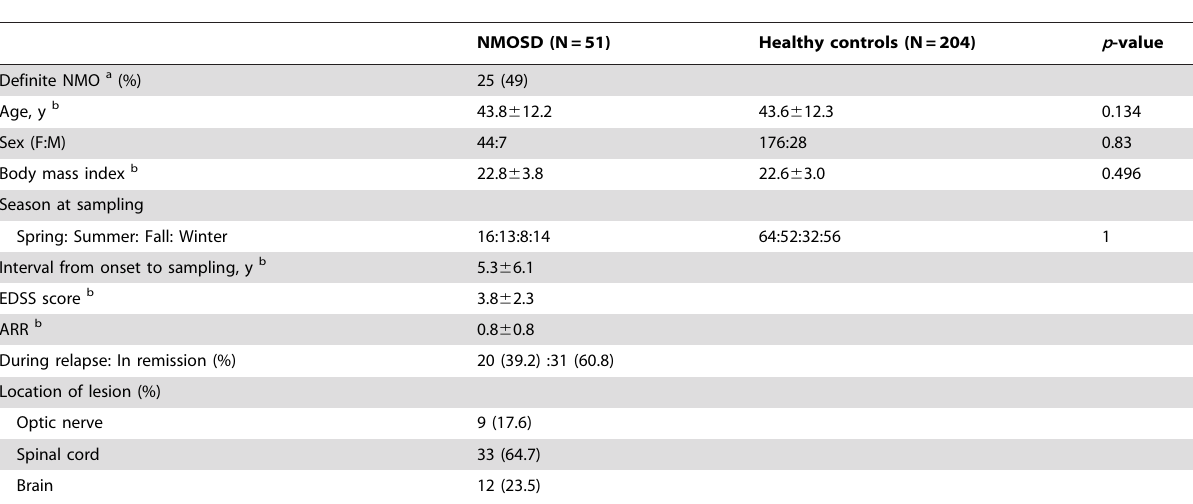
Table 1. Demographic features of patients with neuromyelitis optica spectrum disorder and healthy controls.